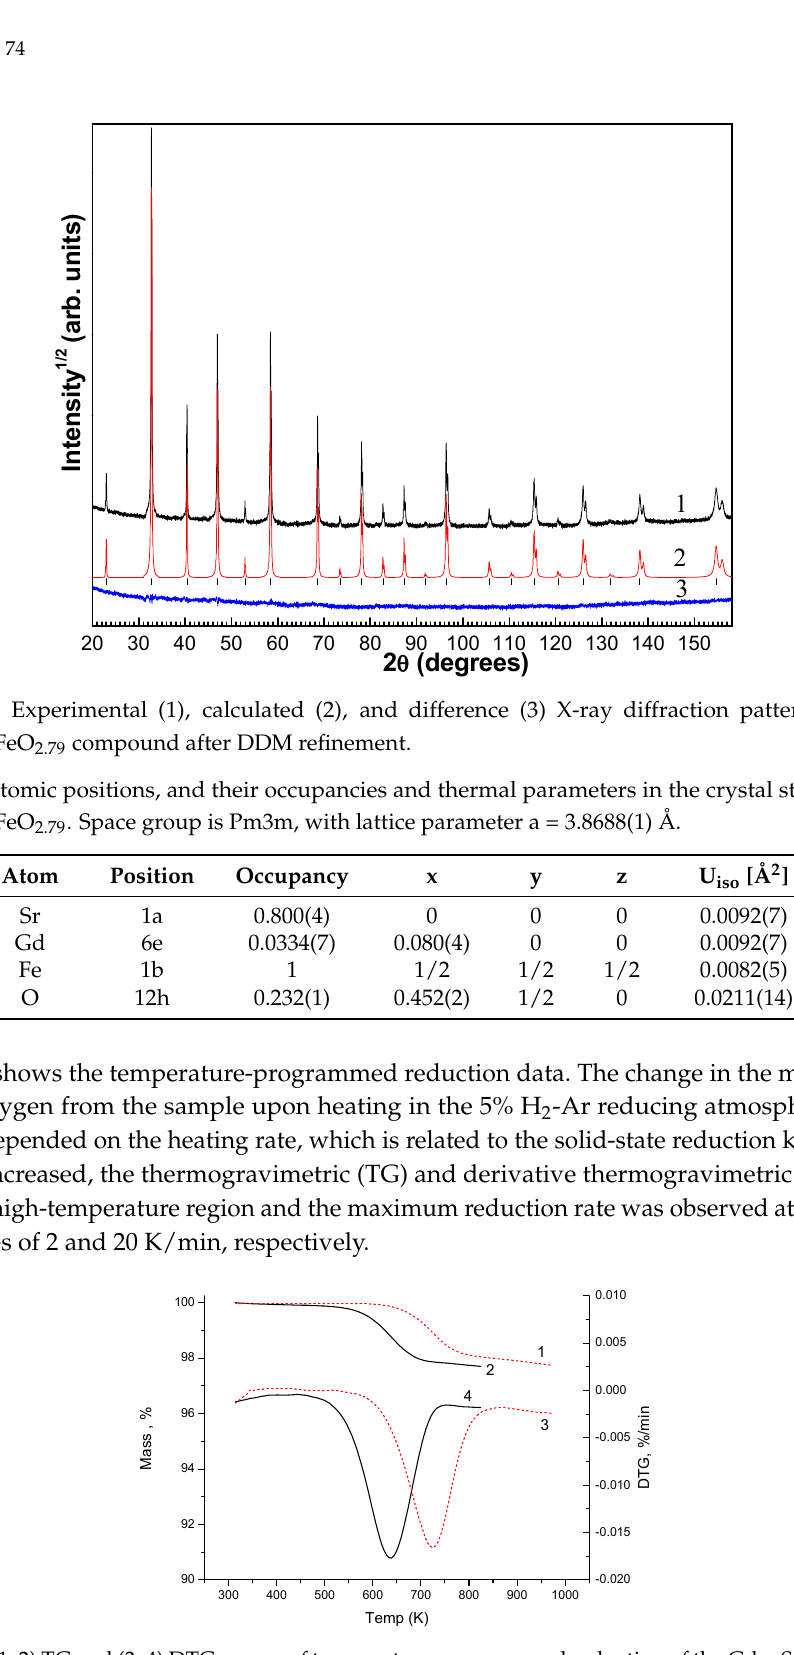
Figure 2. (1, 2) TG and (3, 4) DTG curves of temperature-programmed reduction of the Gd 0.2 Sr 0.8 FeO 2.87 compound in the 5% H 2 -Ar mixture flow at heating rates of 2 (black solid curve) and 20 K/min (red dotted curve).